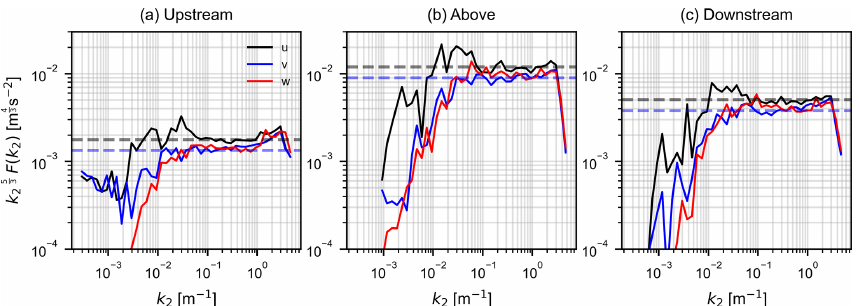
Figure 7. An illustration of the compensated spectra in terms of wave number k 2 . These specific spectra represent flight 33 (weak stability). The dashed black and blue lines represent the average values for u and v spectra, respectively, in the inertial subrange.